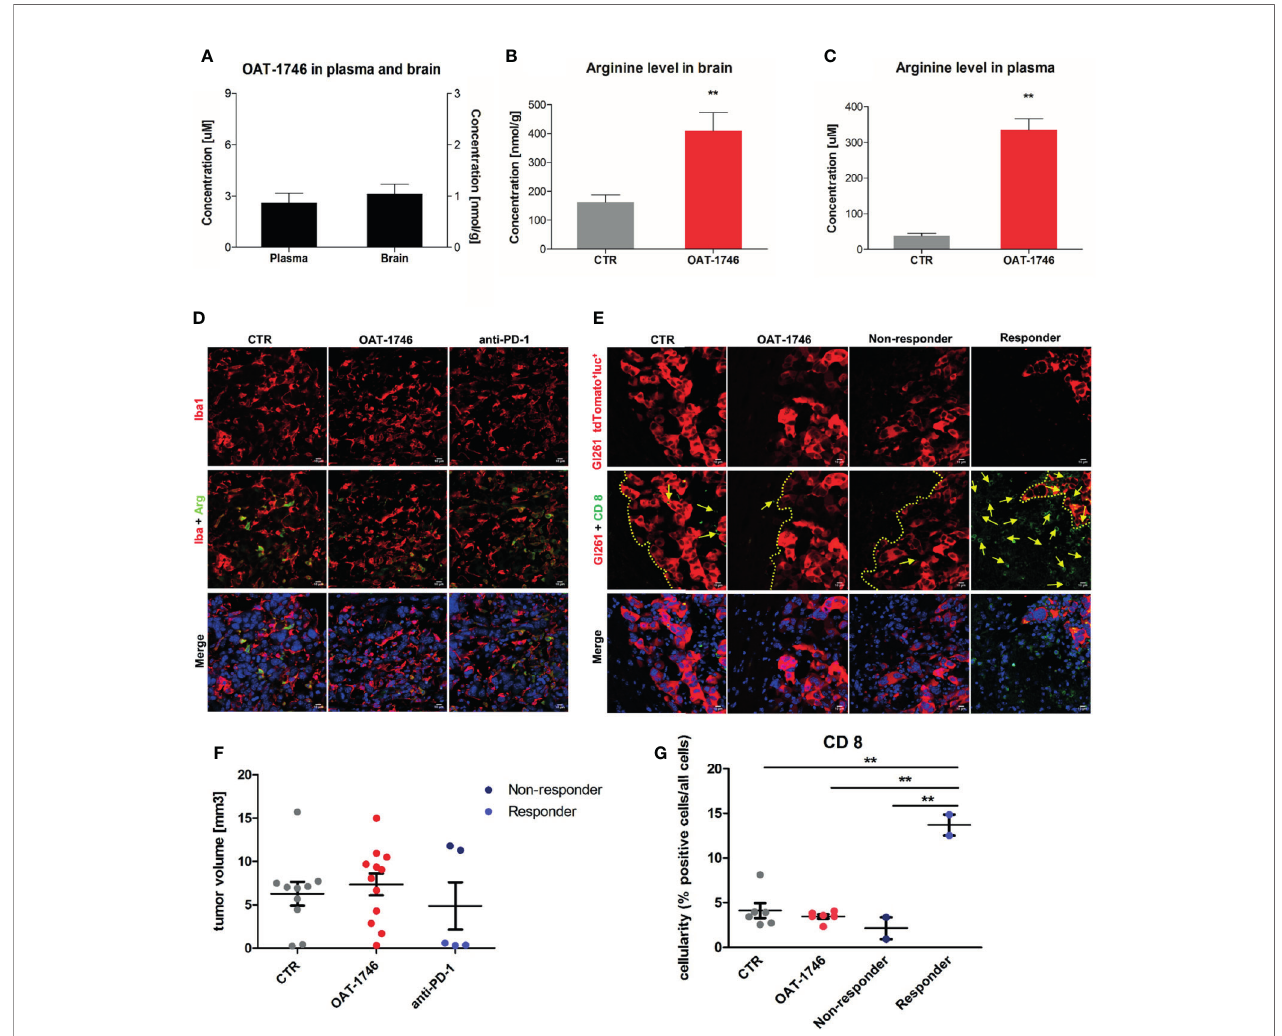
FIGURE 3 | Treatment with OAT-1746 increases arginine levels in the brain and plasma but has no antitumor activity against murine GL261 gliomas. (A – C) Tumor- bearing mice were treated with OAT-1746 twice a day and samples were collected 2 h after the last dosing (n=6 per group). Concentrations of OAT-1746 (A) and L-arginine in tumor-bearing brains (B) and plasma (C) from the same animals were measured by LC/MS at day 14 post-implantation. The results were compared using the non-parametric Mann-Whitney test. **p < 0.01. (D) Mice with implanted GL261 tdTomato + luc + glioma cells received orally saline CTR (n=12) or OAT-1746 50 mg/kg twice a day for 21 days (n=12). A separate group received anti-PD-1 antibody (2.5 mg/kg, i.p.) at days 8, 10, 12 and 14 (n=5). Representative images of the glioma-bearing brains (at day 21) stained with anti-Iba1 (in red) and anti-Arg1 (in green) antibodies, and co-stained with DAPI are shown. (E) Representative confocal microscopy images of CD8 + T and NK cells within the tumors after OAT-1746 or anti-PD-1 antibody administration. The yellow line separates tumor areas (with glioma cells showing red fl uorescence) and the parenchyma border; cell nuclei are counterstained with DAPI (blue); magni fi cation x60. Yellow arrows indicate the accumulation of CD8 + cells (in green) in the responder PD-1 inhibition but not in the non-responder. (F) Quanti fi cation of tumor volumes at day 21 post- implantation. Each individual from CTR (n=12), OAT-1746 (n=12) and anti-PD-1 (n=5) groups is shown. In the checkpoint inhibitor treatment group non-responders (n=2) and responders (n=3) are marked in dark and light blue, respectively. Tumor areas were measured using ImageJ in every sixth brain slice, and tumor volumes were calculated; the mean ± SEM, p values were calculated using the Mann – Whitney U-test. (G) Quanti fi cation of CD8 + cells related to the total number of cells in the area of interest. The cells were counted using ImageJ software and average values from 5 fi elds are presented. Signi fi cance was calculated with One-Way ANOVA, Bonferroni ’ s multiple comparison test was used to compute p values (CTR n=6; OAT-1746 n=6, anti-PD-1 n=4); **p < 0.01.